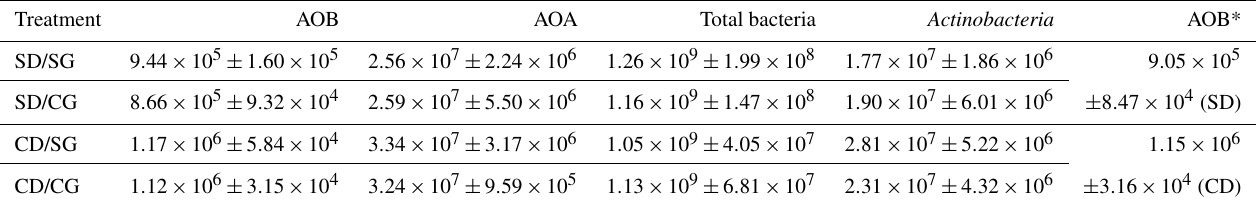
Table 3. Copy number (copies µg − 1 DNA) of the indicator genes assessed for the different microbial groups. SD/SG: no dry–rewetting/no herbicide; SD/CG: no dry–rewetting disturbance/herbicide; CD/SG: dry–rewetting disturbance/no herbicide; CD/CG: dry–rewetting distur-